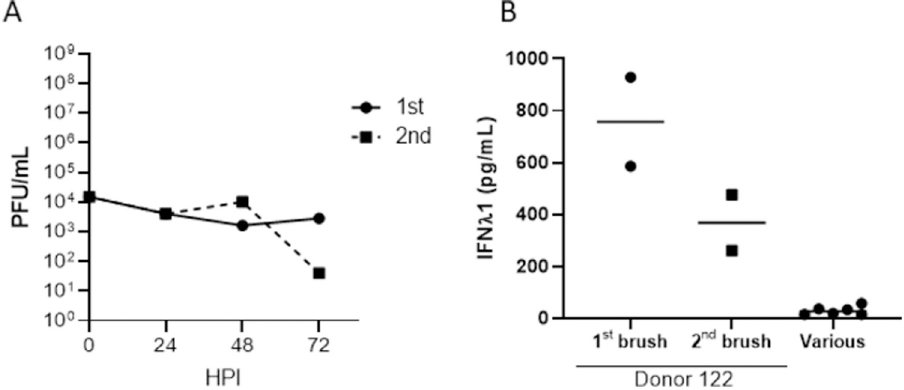
Fig 3. Resistance to SARS-CoV-2 infection and pre-activated interferon pathway was not transient. Independent nasal brushes were obtained from donor 122 four months apart, designated 1 st brush and 2 nd brush (1 st brush